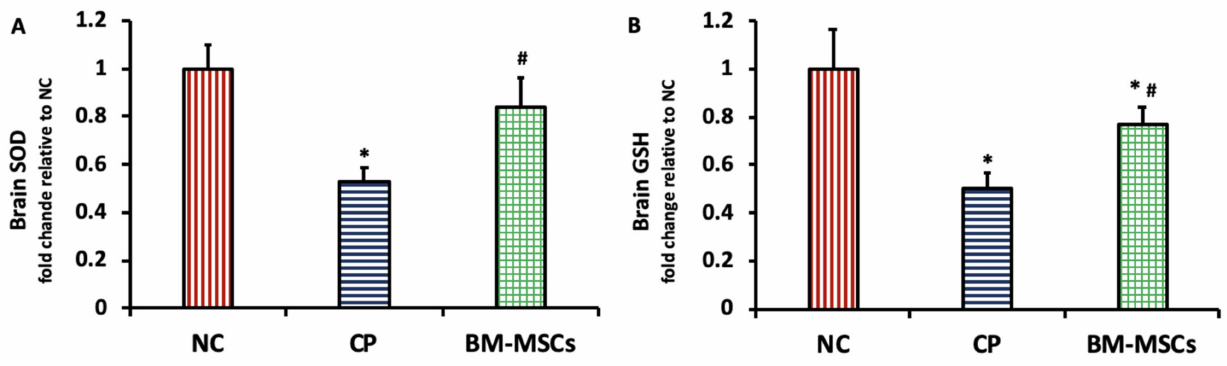
Figure 4. Impact of BM-MSCs injection on SOD ( A ) and GSH ( B ) in the brain tissue of CP-intoxicated rats. Data are presented as mean ± SD, n = 5. * p < 0.05 vs. NC group, # p < 0.05 vs. CP group. NC: normal control, CP: cisplatin, BM-MSCs: bone marrow-derived mesenchymal stem cells, SOD: superoxide dismutase, GSH: reduced